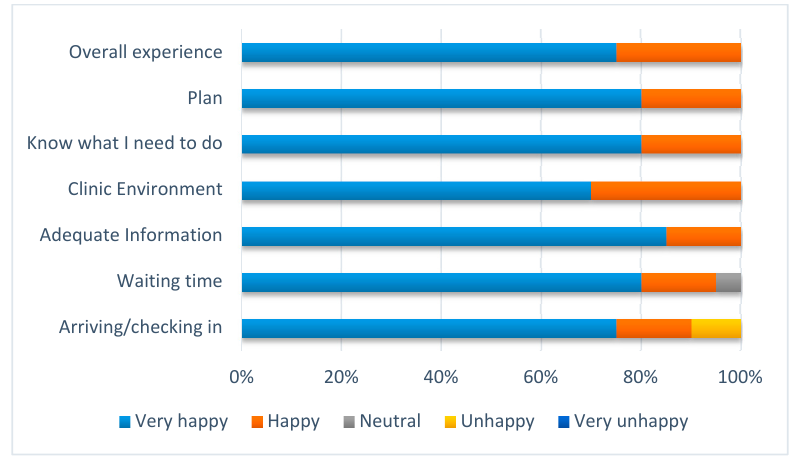
Figure 1. Patient feedback.